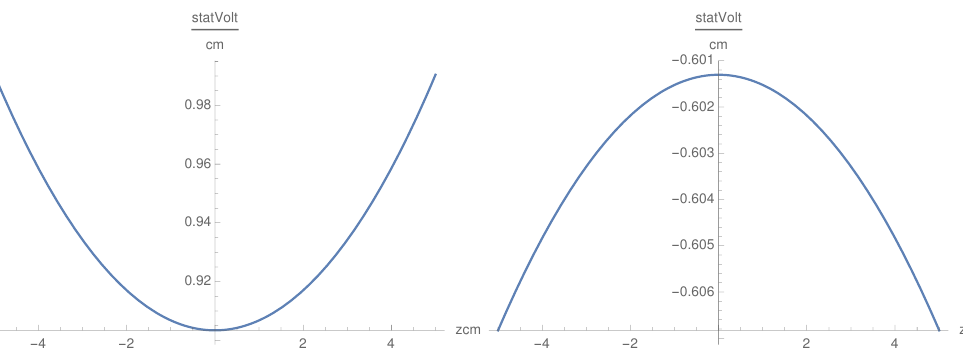
Figure 6. E z ( x , z , ω ) as a function of x for some values of z and ω : ω = 1.4 × 10 9 Hz and z = 2 cm ( left ), and z = 4.1 cm and ω = 1.4 × 10 9 Hz ( right ).